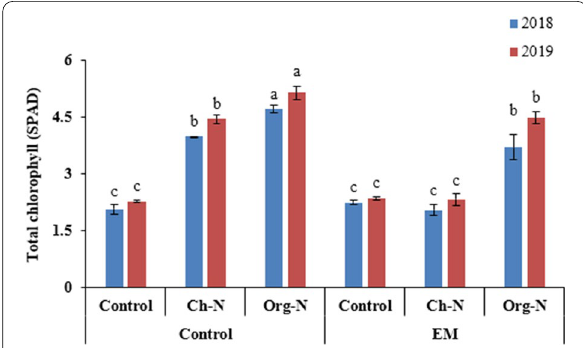
Fig. 3 Effect of different nitrogenous fertilizers and effective microorganisms on leaf chlorophyll contents of stevia during two growing seasons (2018–19). Ch - N chemical nitrogenous fertilizer, Org-N organic nitrogenous fertilizer, EM effective microorganisms. Each value expressed in figure is mean of two cuttings. Vertical bars indicate mean standard deviation. Means followed by the same ± letter within the same series are not significantly different according to Fisher’s least significant difference (LSD) technique (p 0.05) ≤